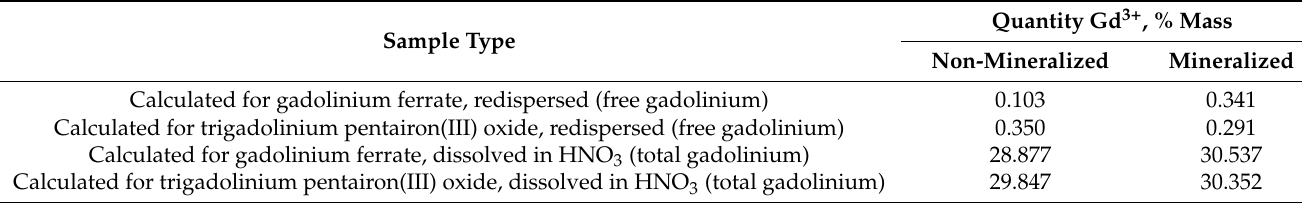
Table 2. Quantity of total and free gadolinium in samples.